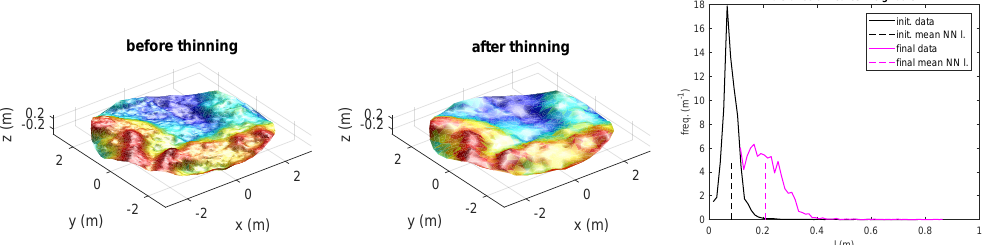
Figure 4. Left : The TIN model after SAF. Middle : The TIN model after the thinning process where the average triangle edge length has been forced to 20 cm. Right : Initial and final NN distance distributions. The mean point distance ¯ l has been shifted from initial 0.07m to 0.20m. Bottom right : Definition of the NN distance as an average of the TIN triangle side